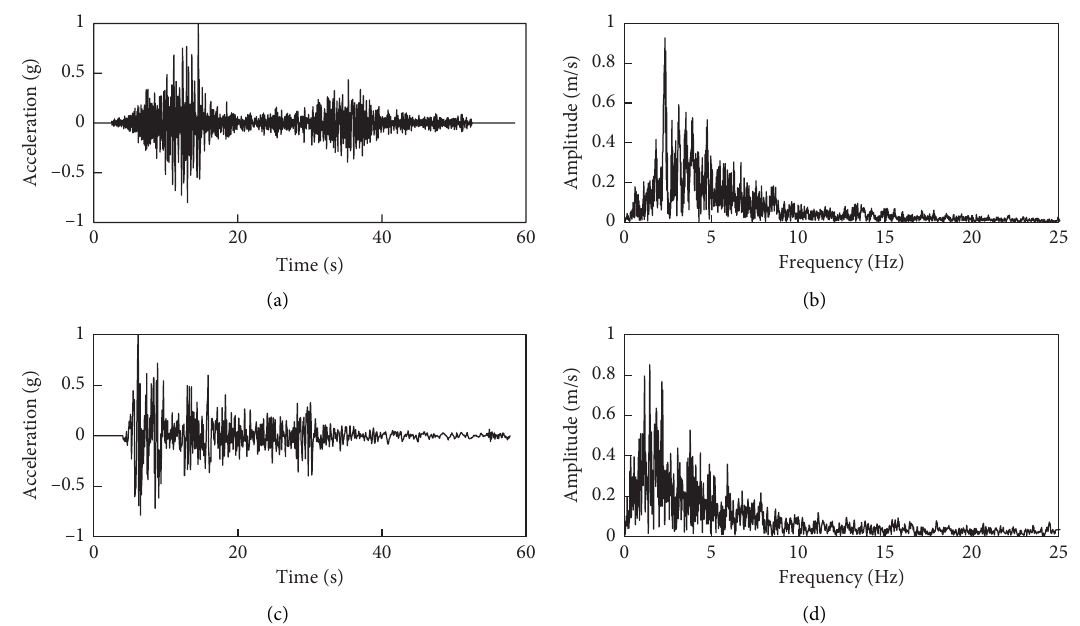
Figure 7: Time history of earthquake motion and fourier spectra. (a) WL. (b) WL fourier spectra. (c) EL. (d) EL fourier spectra.